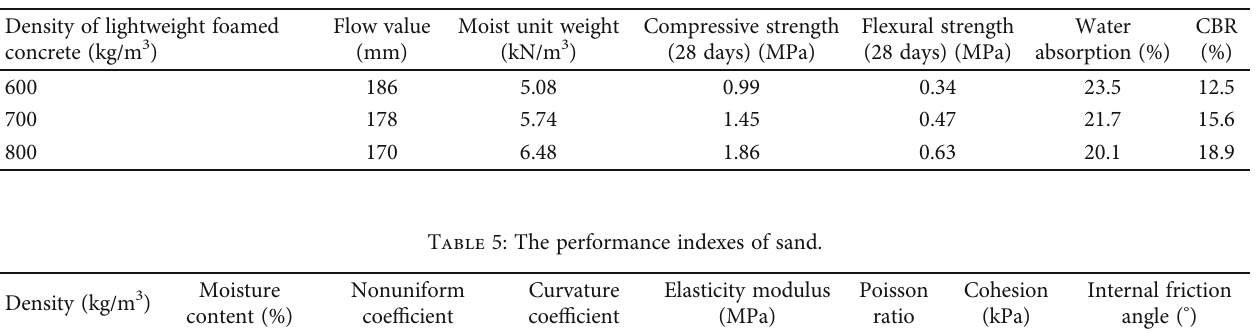
Table 4: The performance indexes of lightweight foamed concrete.